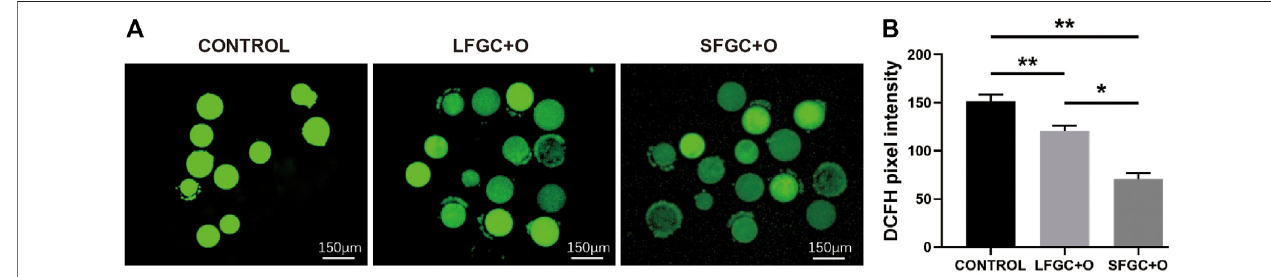
FIGURE4| EffectsofGCco-cultureonROSproductioninmareMIIoocytes. (A) Representative fl uorescenceimageswereobtainedfrommareMIIoocytesstained withDCFH-DA.Scalebar=150 μ m. (B) Relative fl uorescenceintensityofDCFH-DAinmareMIIoocytesderivedfromtheCONTROL,LFGC-O,andSFGC-Ogroups(30 oocytes per group). Average optical intensity was measured using ImageJ. Data are expressed as means ± SEM. * p < 0.05, ** p < 0.01.